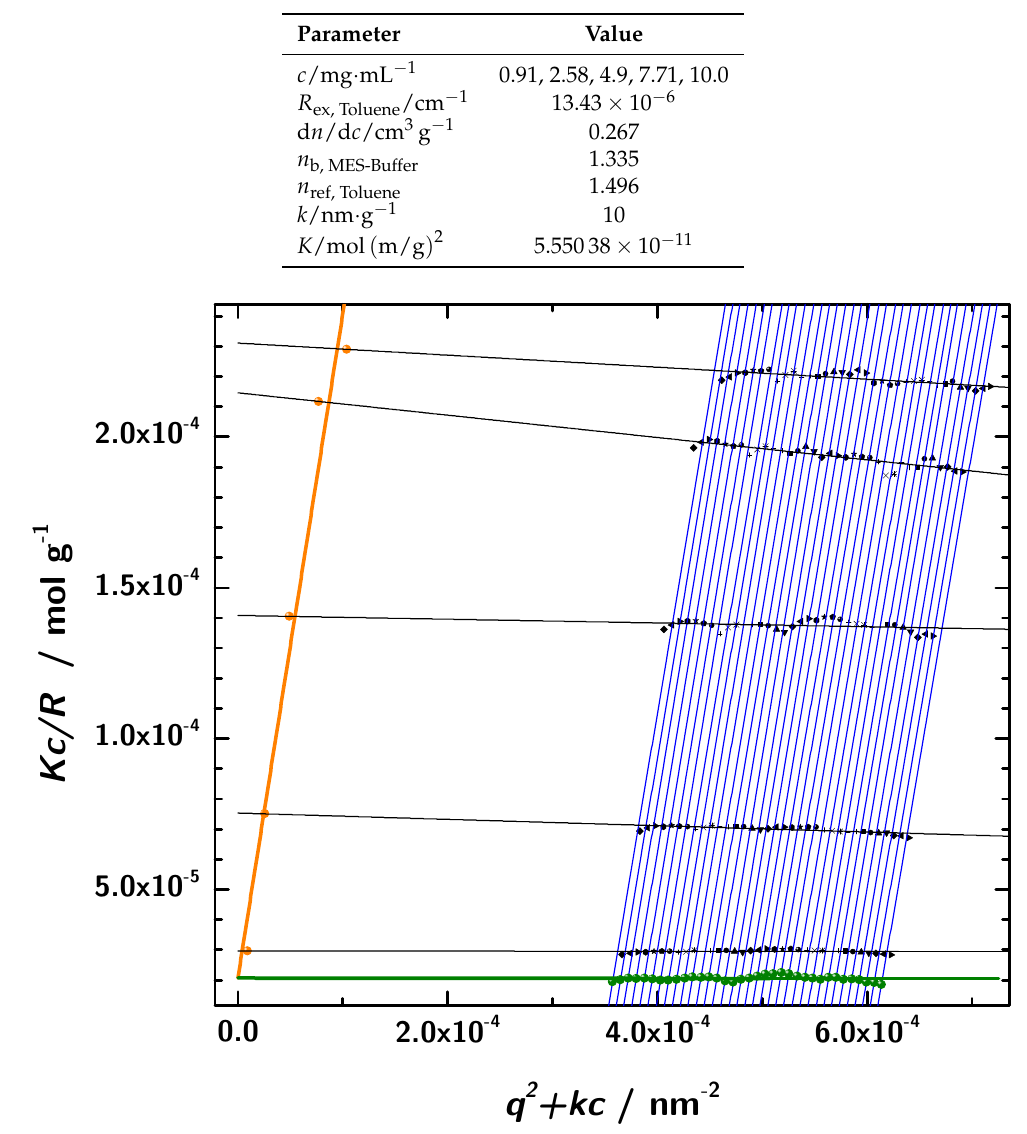
Table 4. Parameters used for the Zimm-analysis. The listed parameters are input values for the analysis and are defined in the Materials and Methods section. The given refractive index increment dn / dc results from measurements on our 3H3 samples and is about 25 % larger compared to values reported in the literature [65].